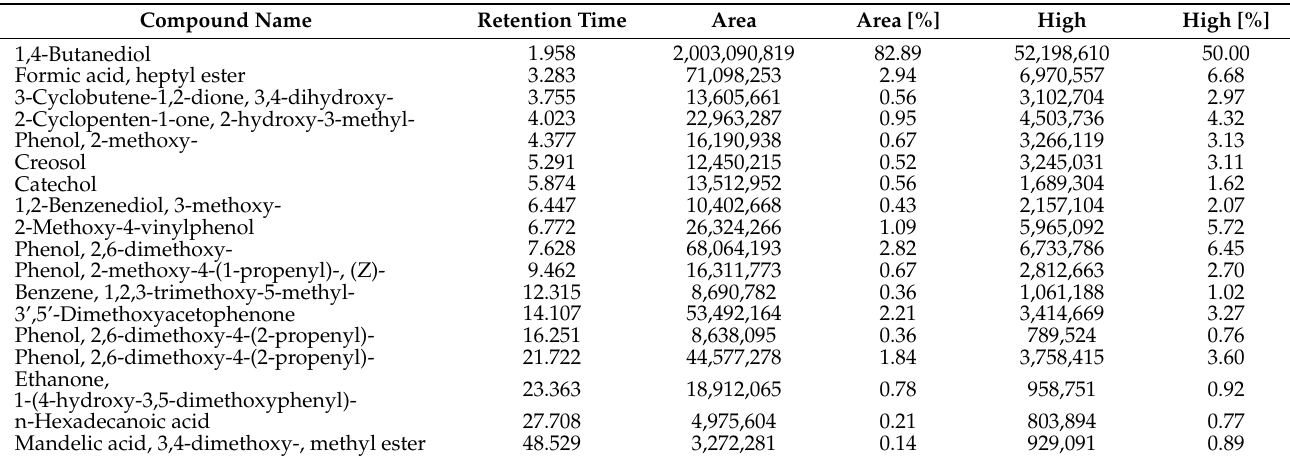
Table 5. Juxtaposition of emissions of isolated substances, 450 ◦